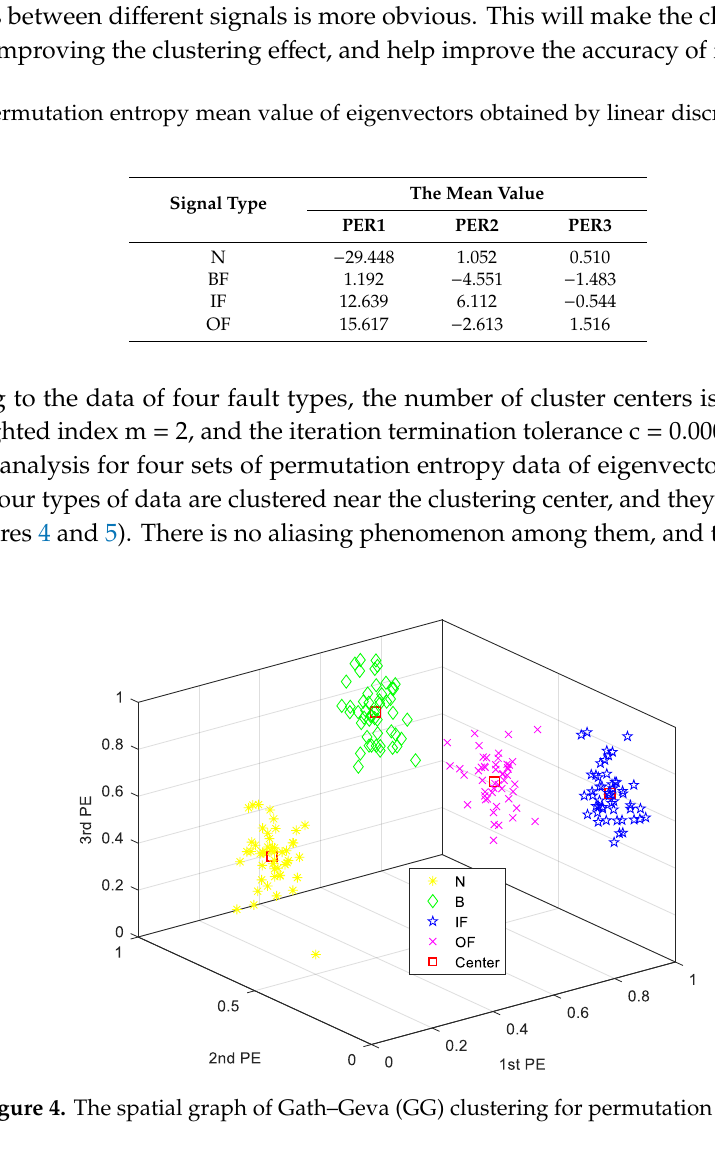
Figure 5. The GG clustering contour for permutation entropy. The clustering centers of data are shown in Table 3. The clustering centers of the four signal types are V1 – V4 in turn. Figure 6 shows the average Hamming approach degree of each sample set. The Hamming approach degree of Group 1 relative to V1 is 0.9442, close to 1, and larger than that of the other three groups. Therefore, Group 1 belongs to V1. Similarly, Group 2 belongs to V2, Group 3 belongs to V3, and Group 4 belongs to V4. Therefore, this proposed method has good performance in the fault diagnosis of rolling bearings. Table 3. The clustering centers of the four types of signals. Signal Type